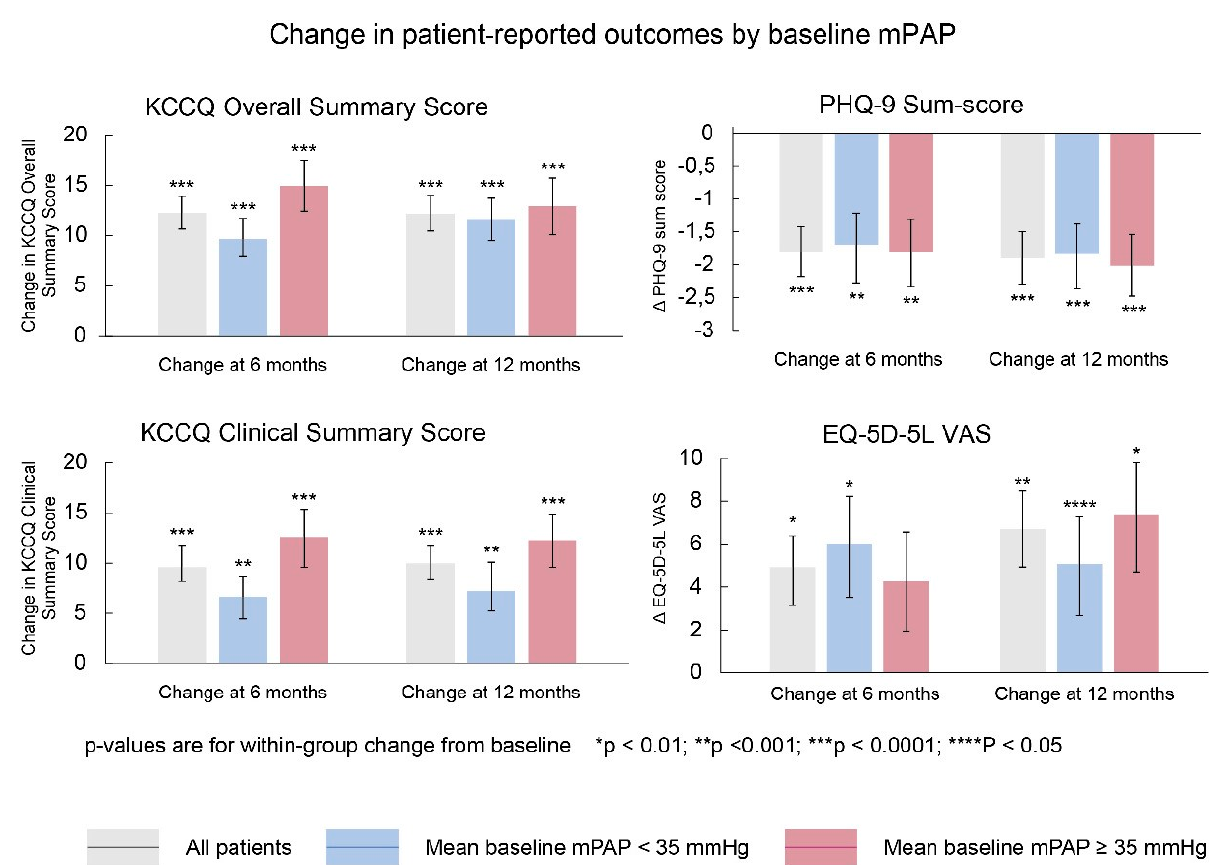
Figure 6. Changes in patient-reported outcomes by baseline mean pulmonary artery pressure (mPAP) as reported in the MEMS-HF study. CSS, clinical summary score; KCCQ, Kansas City Cardiomyopathy Questionnaire; OSS, overall summary score; PHQ-9, 9-item Patient Health Questionnaire; VAS, visual analogue scale. Reprinted from the European Journal of Heart Failure, Volume 22, Issue 10, Angermann et al., Pulmonary artery pressure-guided therapy in ambulatory patients with symptomatic heart failure: the CardioMEMS European Monitoring Study for Heart Failure (MEMS-HF), pages 1891–1901, with permission from Wiley [6].